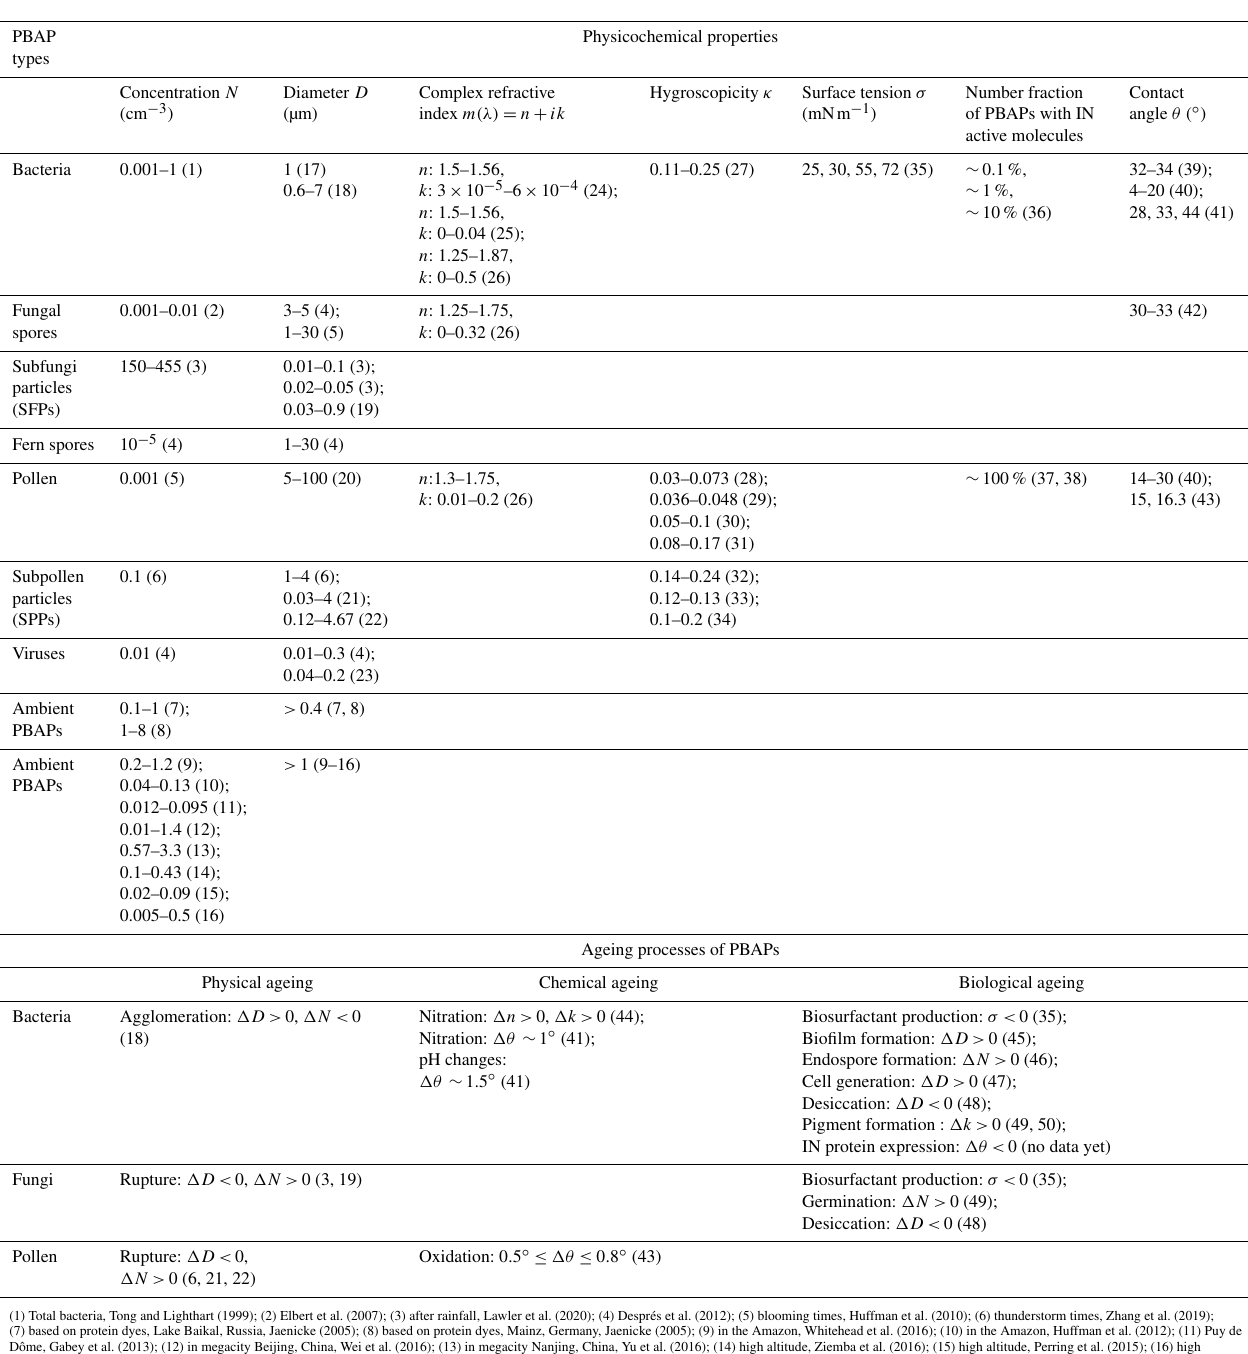
Table 1. Physicochemical properties of various types of PBAPs and their changes due to physical, chemical, and biological ageing processes based on literature